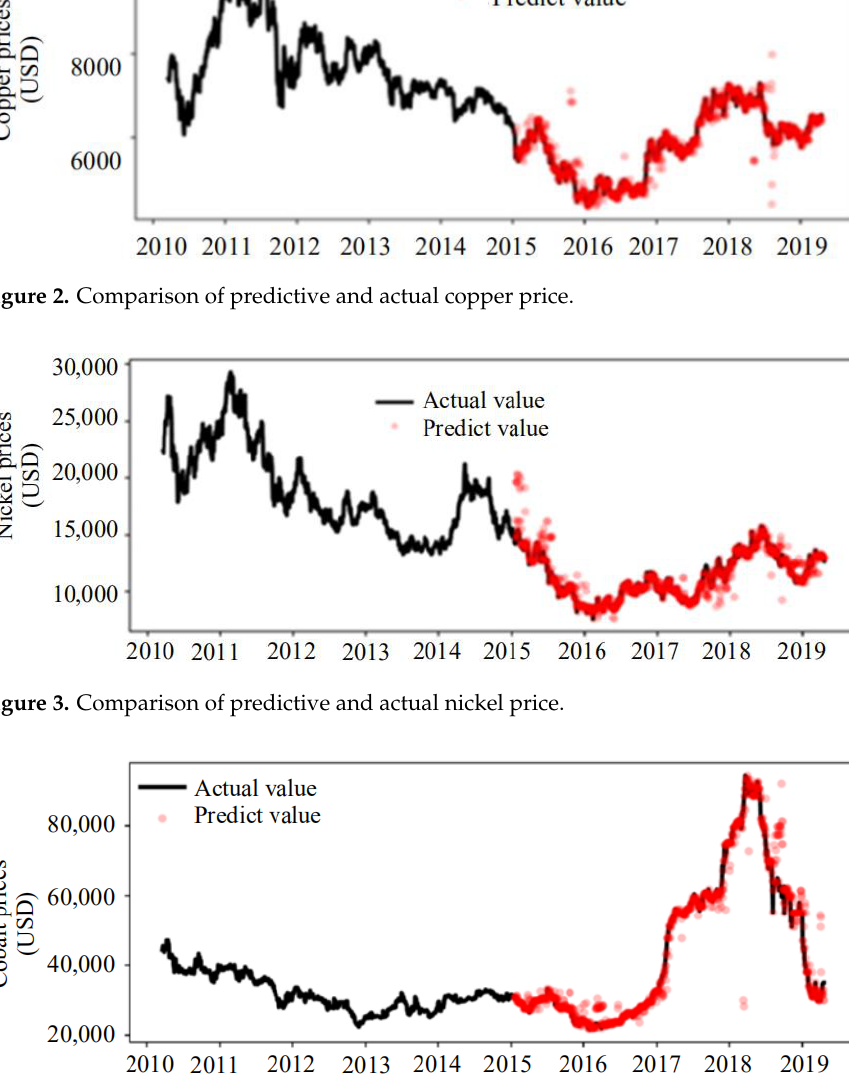
Figure 4. Comparison of predictive and actual cobalt price.